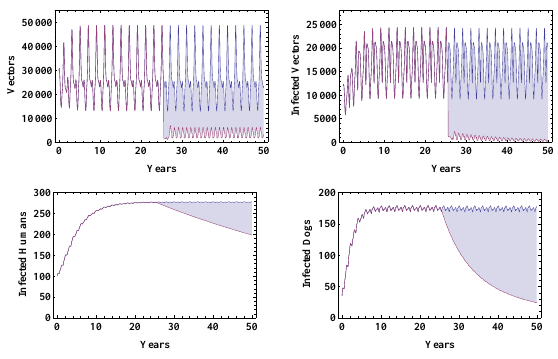
Fig. 2. Case (i): Model variability with 90% reduction of the insecticide effectiveness.